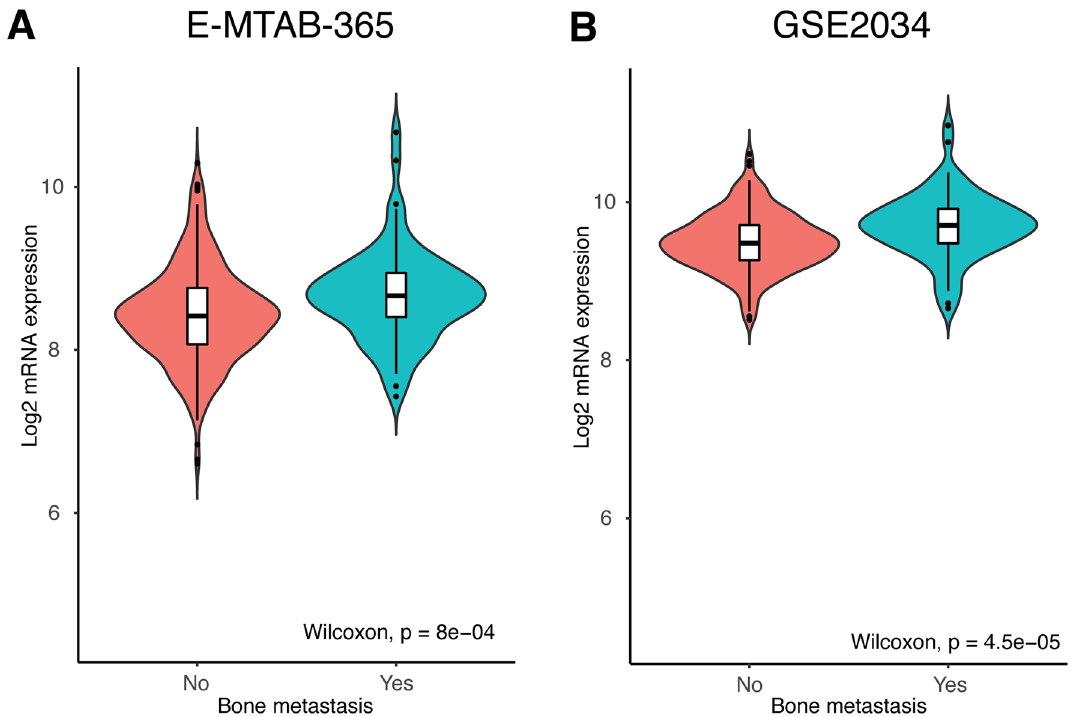
Figure 2. mRNA expression of TOR1B is significantly upregulated in bone metastatic patients in the E-MTAB-356 ( A ) and GSE2034 ( B )